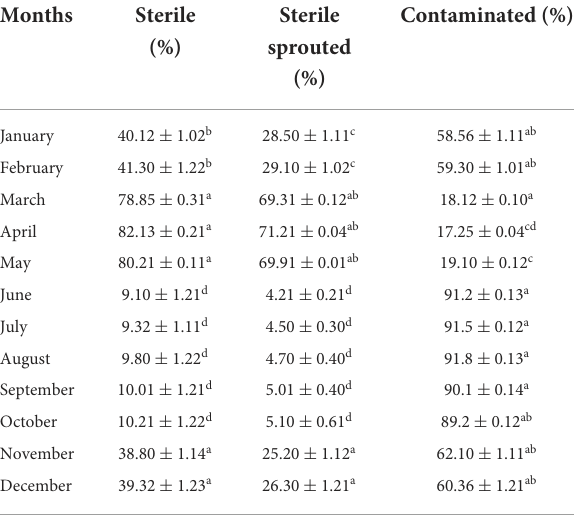
TABLE 1 Response of explant against various seasons (after 15 days of post